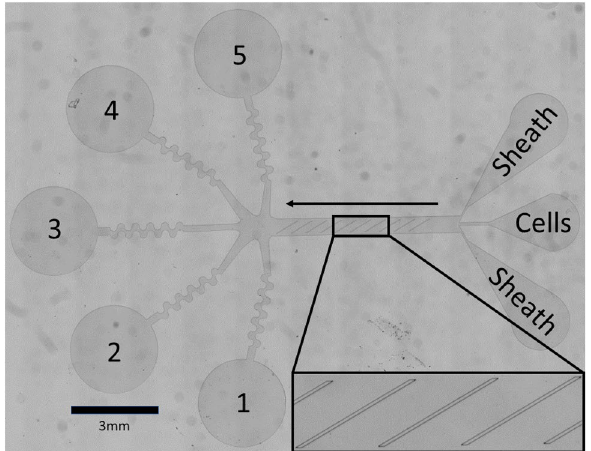
Figure 2. Device overview. The device consists of three inlets and five outlets connected by a sorting channel. Sheath fluid is pumped into the outer two inlets in order to focus the cells from the center inlet to their desired initial lateral position in the device, which in this application was the ‘top’ edge of the ridges (the side of the ridges closest to outlet 5). The cells then flow into the sorting chamber, where they interact with periodic diagonal constrictions (inset) which are designed to force cells to deform in order to pass under them. Large, stiff cells will tend to translate along the ridge (down in the figure, towards outlets 1–3) whereas small, soft cells will pass under the ridges without deflecting and be collected in outlets